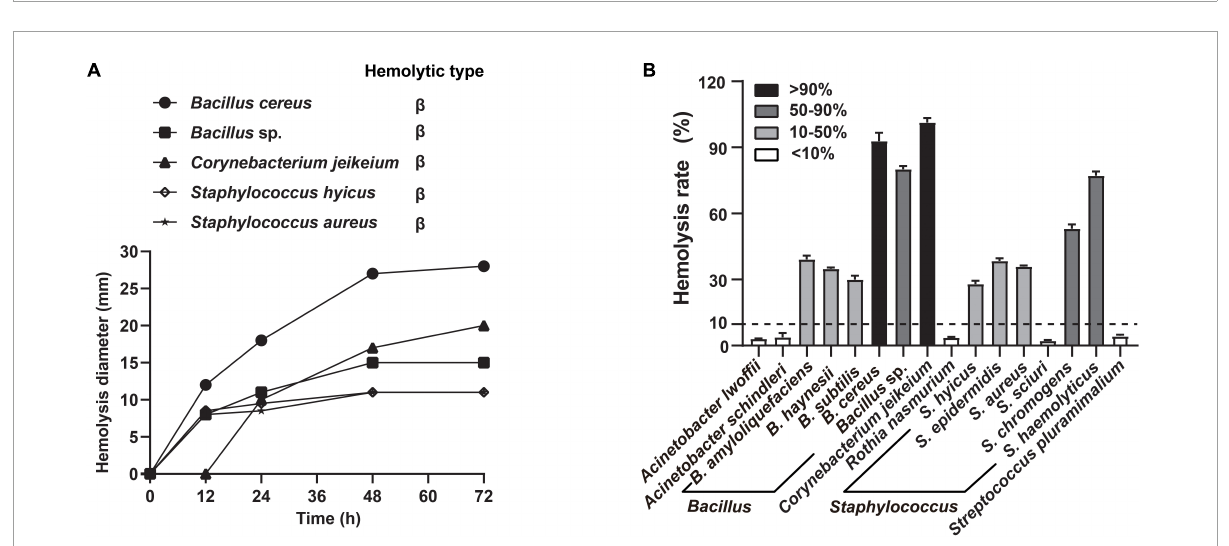
( Supplementary Table 2 and Supplementary Figure 3 ).